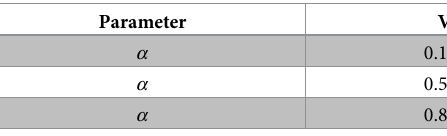
Table 3. Numerical simulation of the varying effects of α